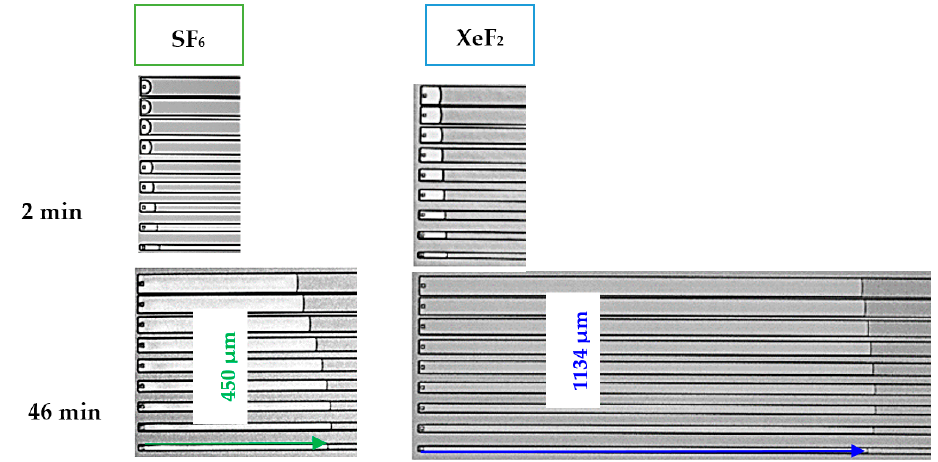
Figure 4. The etch results after 2 min and 46 min for XeF 2 and SF 6 .